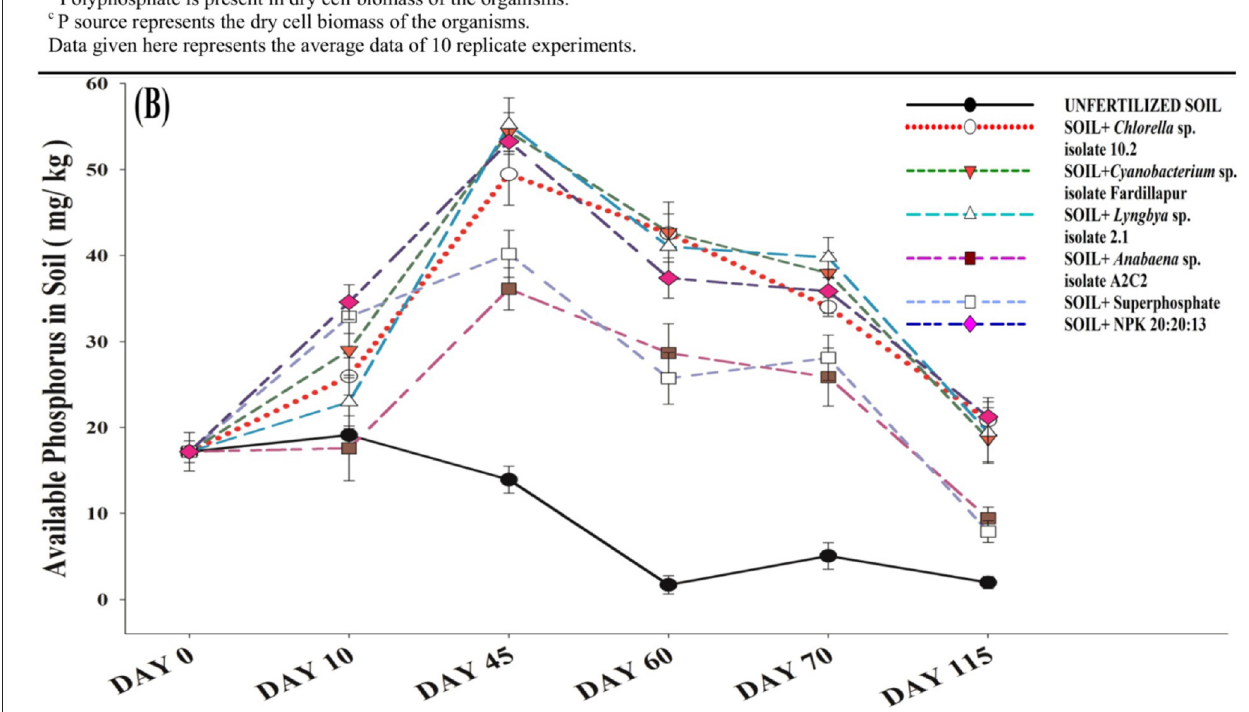
FIGURE 2 | Recycled polyphosphates as substitute to phosphorus fertilizers. (A) Table showing the rate of conversion of polyphosphates accumulated by the microalgae and cyanobacteria into soluble phosphorus and comparison of its release to conventional chemical phosphorus fertilizers commercialized widely in India. (B) Polyphosphate releases soluble phosphorus at a comparable (maximum at 45 days) but slower rate (as reflected in initial 10 days) with recommended dose of superphosphate and NPK at 8–10cm depth of soil. All the points on the graph represent the average data of 10 replicate experiments. Error bars were calculated on the basis of standard deviation of the data using the software SigmaPlot